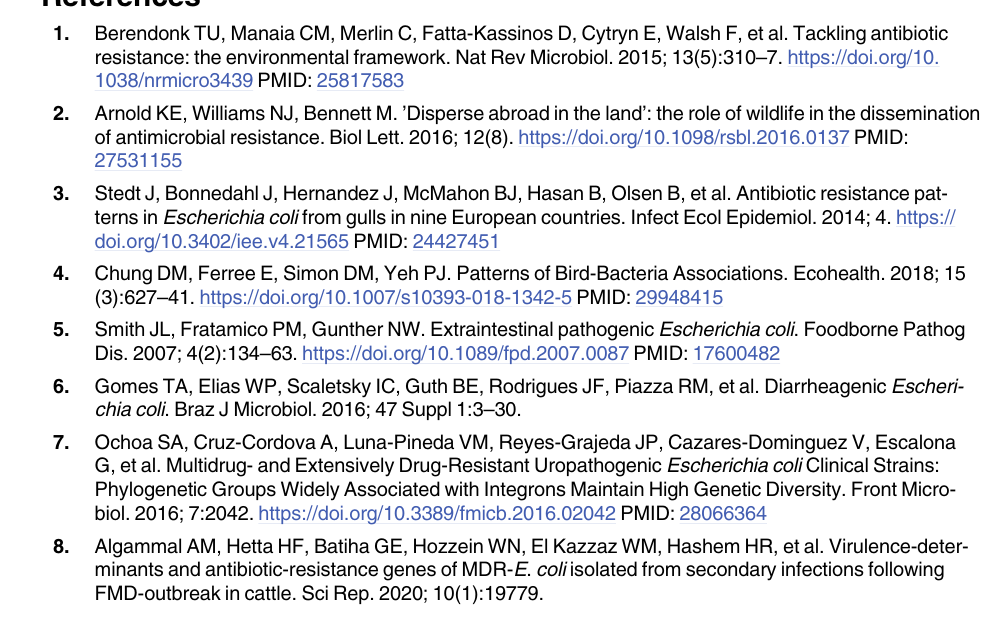
S1 Table. The sequences of the ARGs of the MDR E . coli